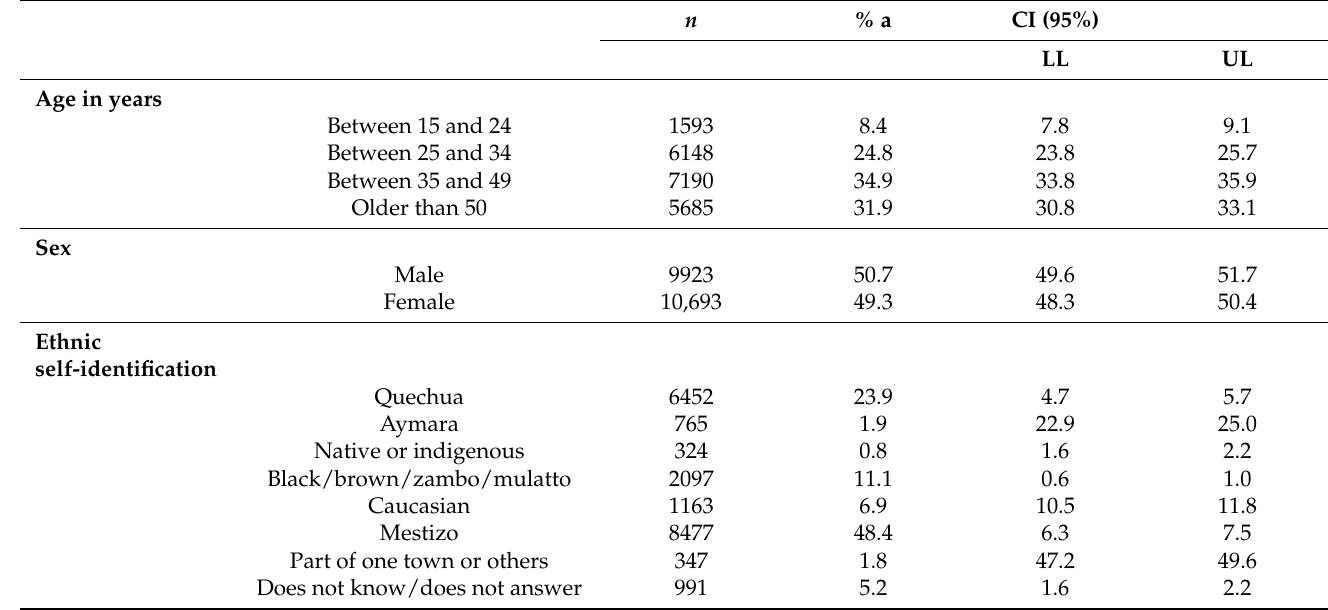
Figure 1. Flowchart showing data obtained from the population through inclusion and exclusion criteria.